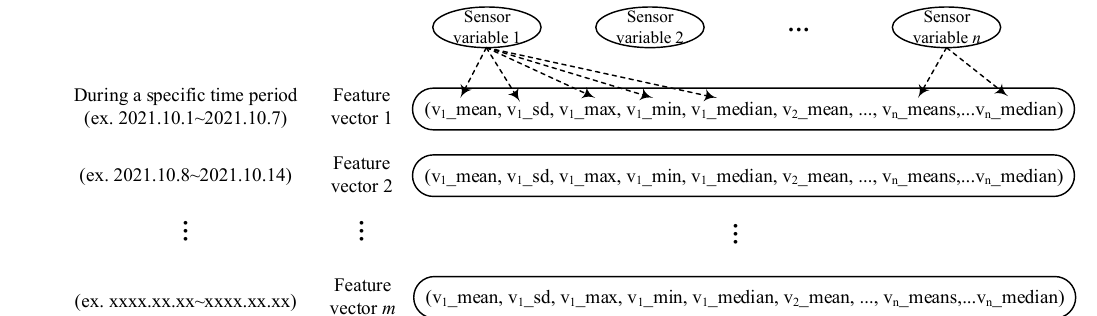
Figure 2. Structure of feature vectors.